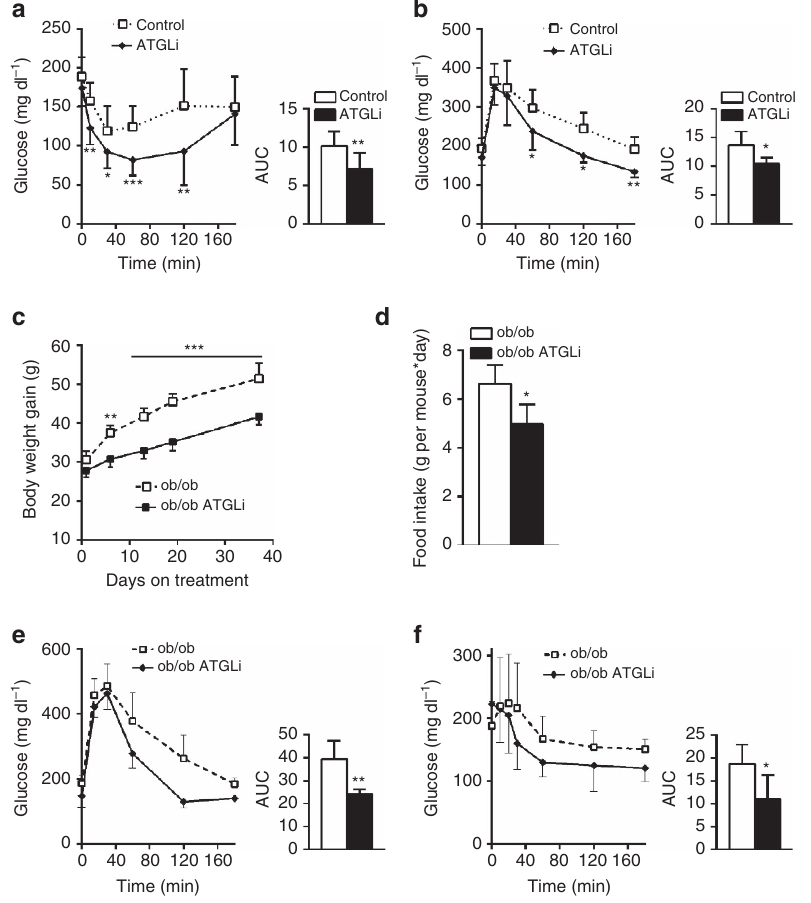
Figure 4 | Atglistatin-mediated inhibition of lipolysis improves glucose homeostasis. ( a , b ) Six weeks old male C57Bl6J mice were fed a HFD (45kJ% fat; 22.1kJg (cid:2) 1 ) for 50 days. Thereafter, mice were fed a HFD in the presence and absence of Atglistatin. ( c – f ) Twenty weeks old ob/ob mice were fed a chow diet in the presence and absence of Atglistatin. ( a , f ) Insulin sensitivity and ( b , e ) glucose tolerance was determined after 30 and 40 days diet intervention by i.p. injection of 0.5IUkg (cid:2) 1 insulin and 1.5gkg (cid:2) 1 glucose, respectively ( n ¼ 6). Area under the curve (AUC) was calculated using GraphPad Prism software. ( c ) Body weight of ob/ob animals fed a chow diet in the presence and absence of Atglistatin ( n ¼ 6). ( d ) Averaged daily food intake of ob/ob animals fed a chow diet in the presence and absence of Atglistatin ( n ¼ 6). Data represent mean ± s.d. Statistical significance was determined